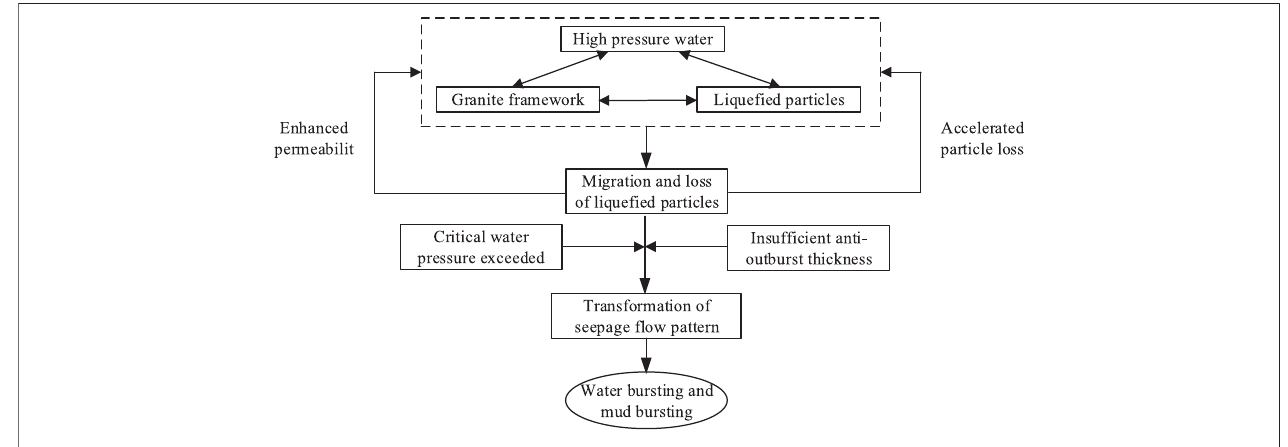
FIGURE 14 | Catastrophic mechanism of water and mud